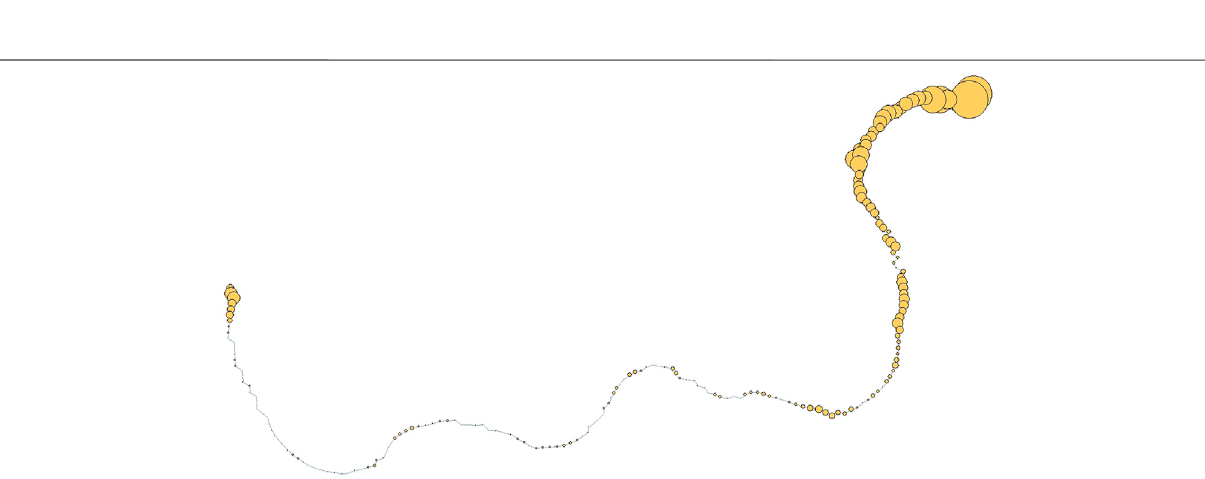
Frontiers in Physics |